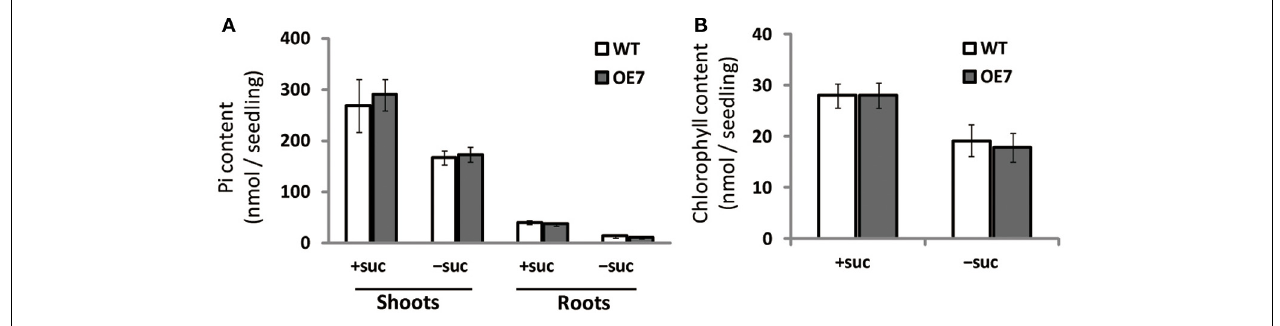
FIGURE 6 | Pi (A) and chlorophyll (B) content in WT and OE7 seedlings grown with or without exogenous sucrose. Plants grown on MS medium supplemented with + suc or − suc for 7d were then